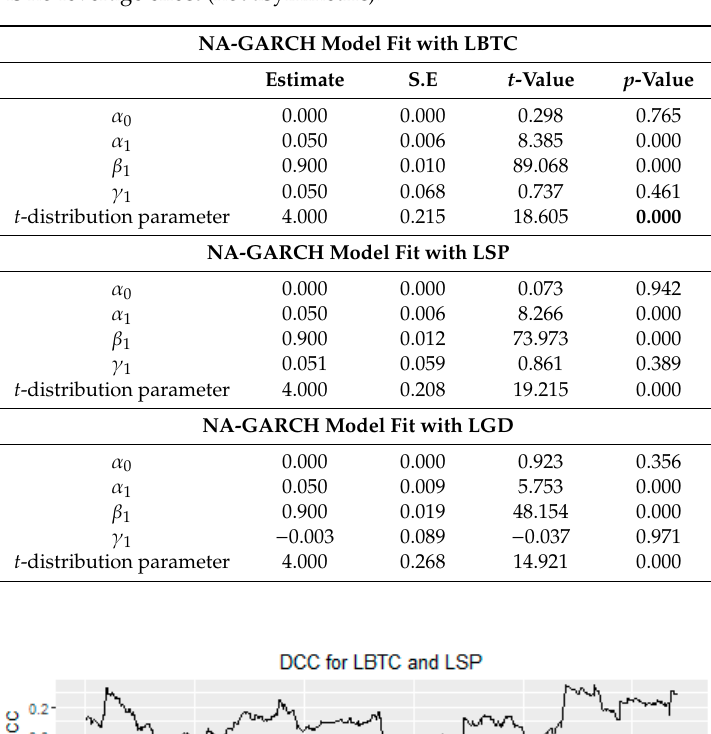
Table 7. Model fit of NA-GARCH (1, 1) where α 0 , α 1 , and β 1 are from Equation (2). Each of all β 1 s